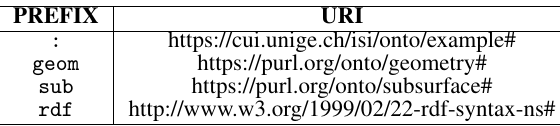
Table 1. Prefixes of the ontologies used in the